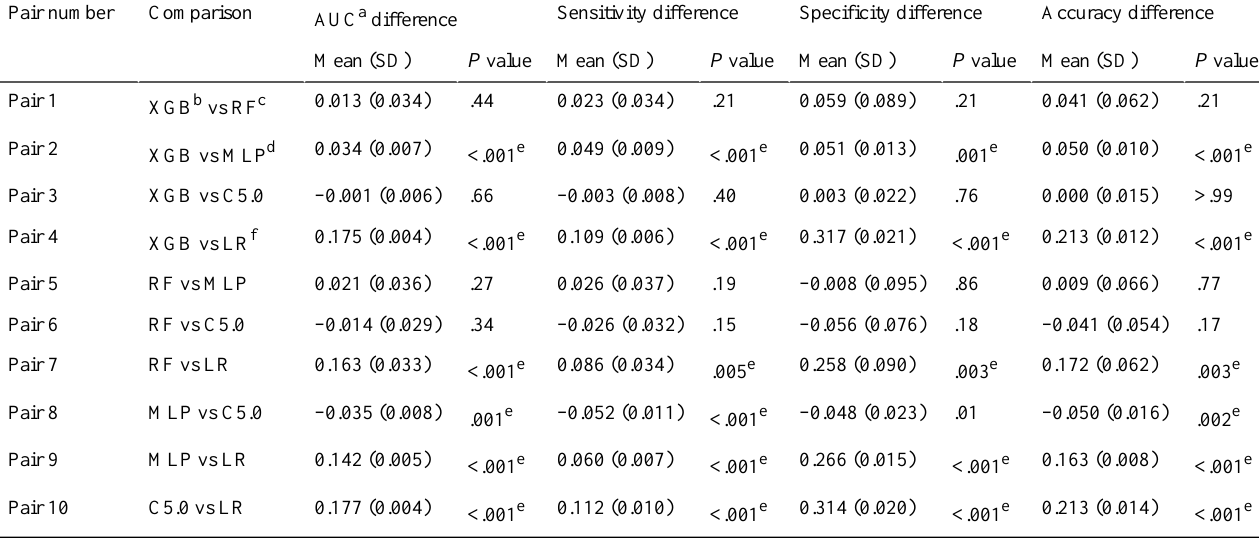
Table 5. Results of the pairwise comparison of the model predictive performance by two-tailed t